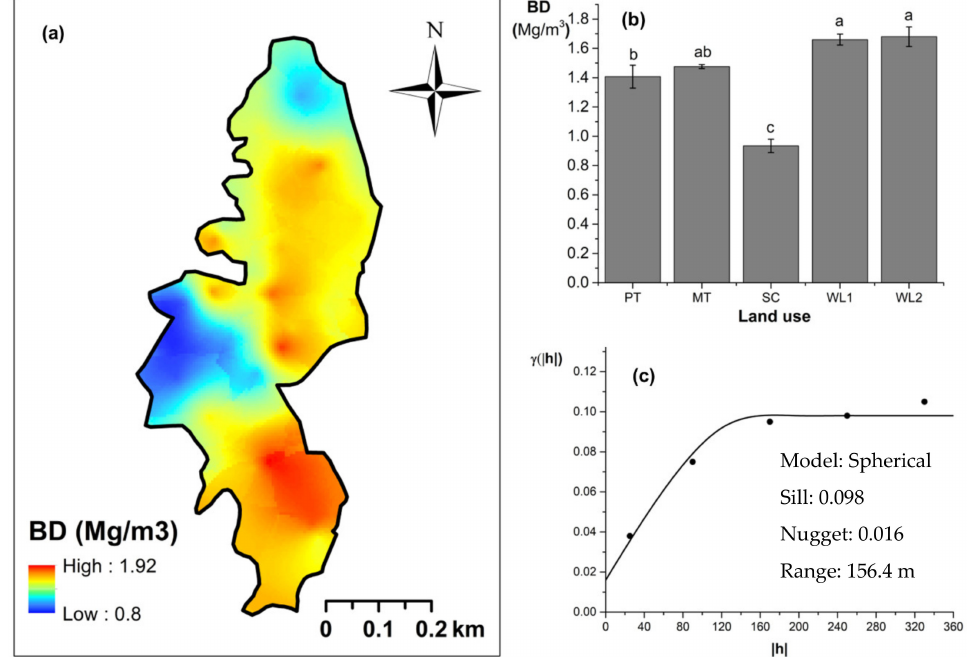
Figure 10. Spatial variation in soil bulk density: ( a ) map, ( b ) bar graph among different land uses (see Figure 1, label A for notations) in the Endane Biodiversity Corridor, and ( c ) variogram between lag distance and semivariance, and ( c ). Semivariance function: γ ( h ) = 0.016 + 0.00093 h − 1.28 × 10 − 8 h 3 . Comparisons depicted by the different letters in the bars in subfigure ( b ) indicate significant pair-wise